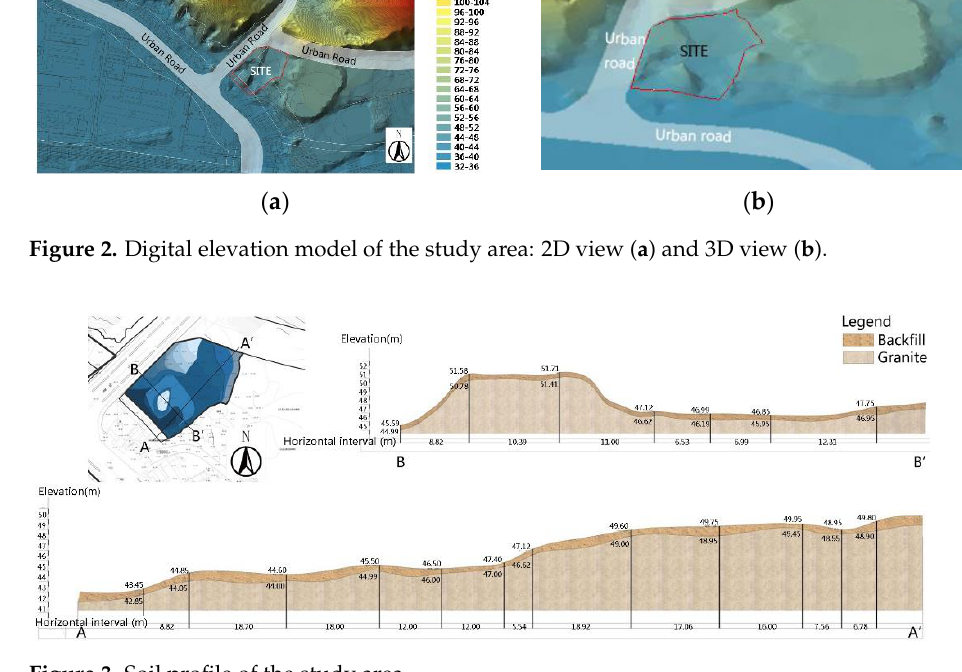
Figure 3. Soil profile of the study area.